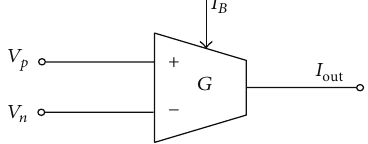
Figure 3: Symbol of